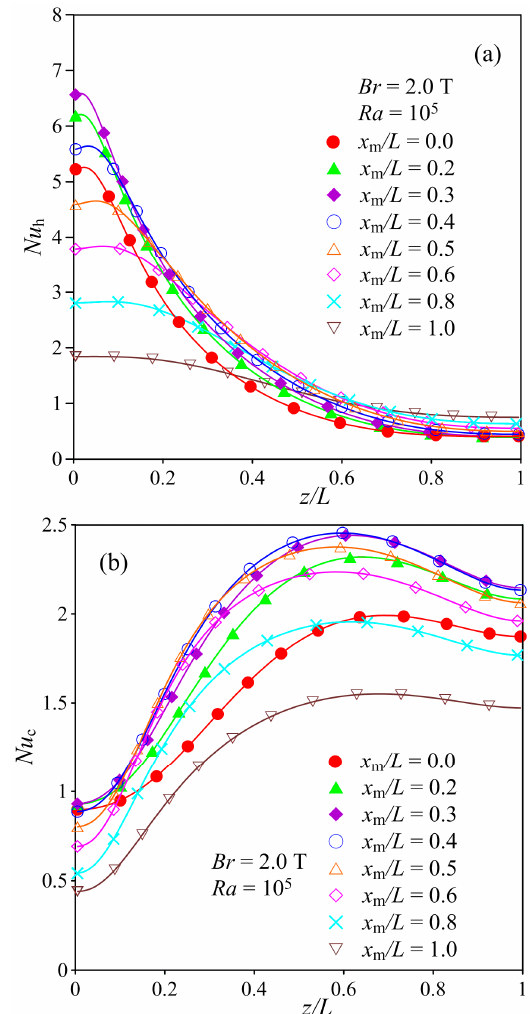
Figure 10. Effect of location of magnet on local Nu ; ( a ) Nu h and ( b ) Nu c .